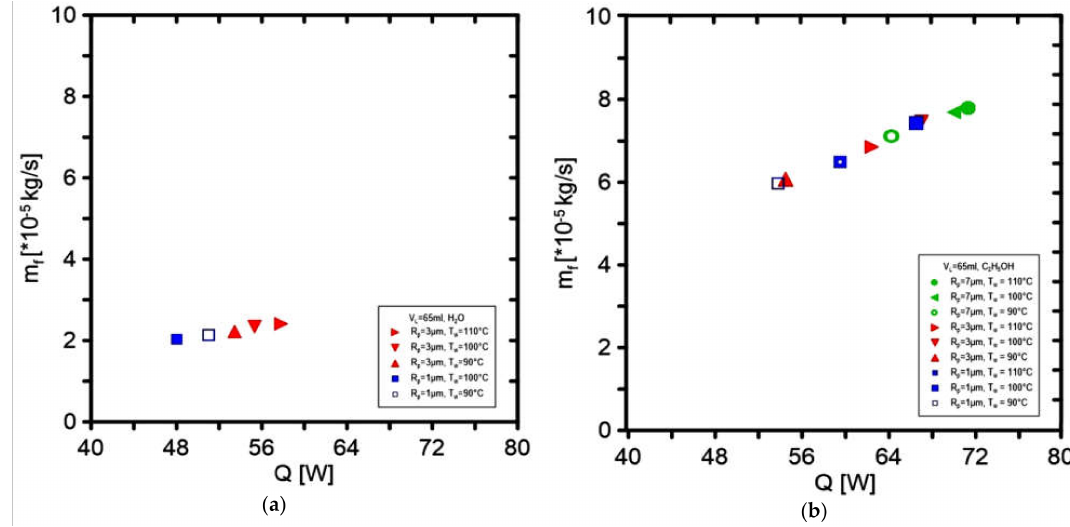
Figure 16. The mass flow rate in the function of applied heat flux for ( a ) water as a working fluid and ( b ) ethanol as a working fluid.